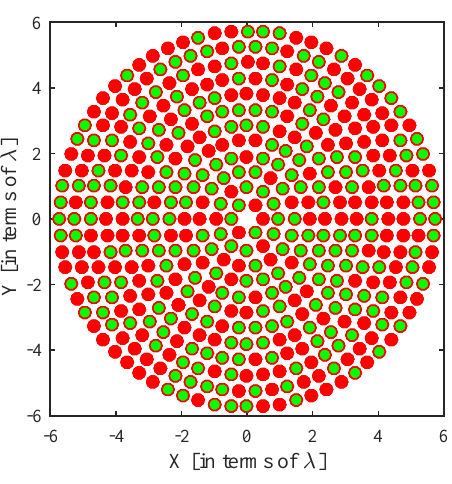
FIGURE 3: Thinned CCRAA using DE